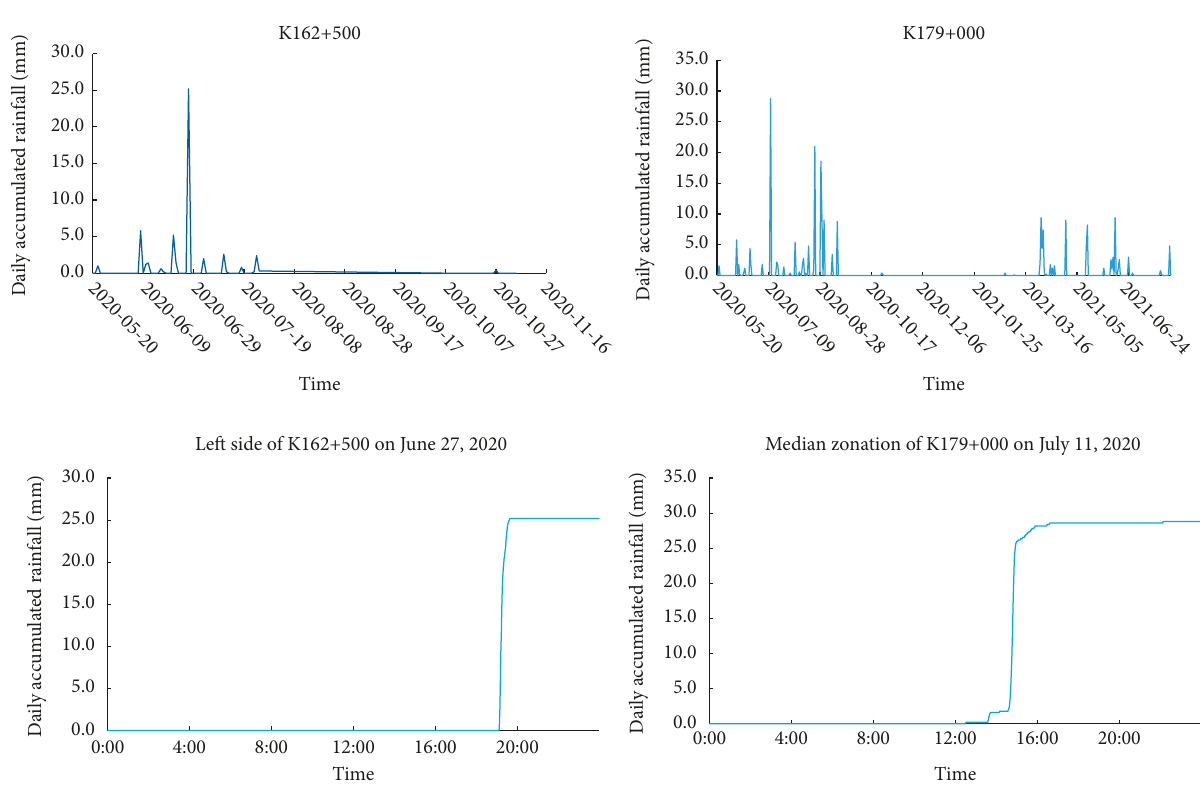
Figure 2: Statistical analysis of rainfall in Wuma expressway. Table 1: Rainfall